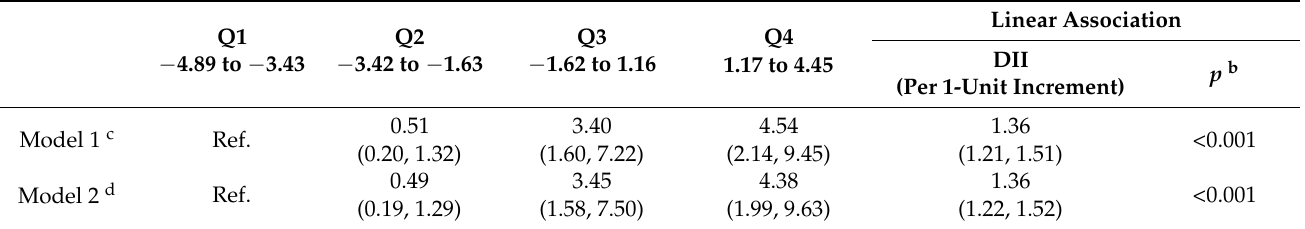
Table 3. The associations [ORs (95% CIs)] between E-DII score quartiles and risk of metabolic syndrome (MetS) among 276 participants a